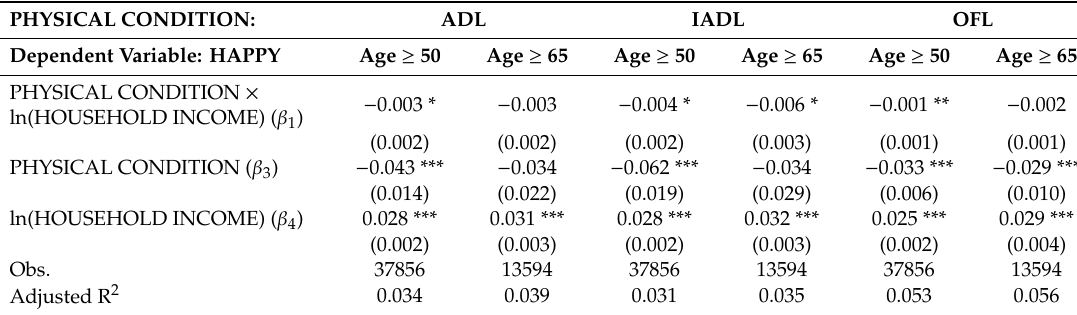
Table 8. Health by physical